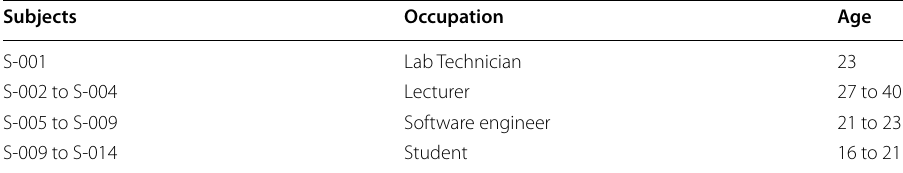
Table 6 Experiment subjects